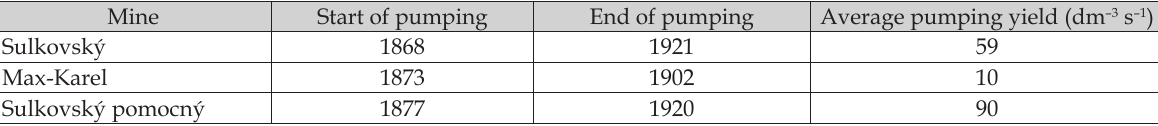
Source: own processing according to Švoma (1980), Stočes